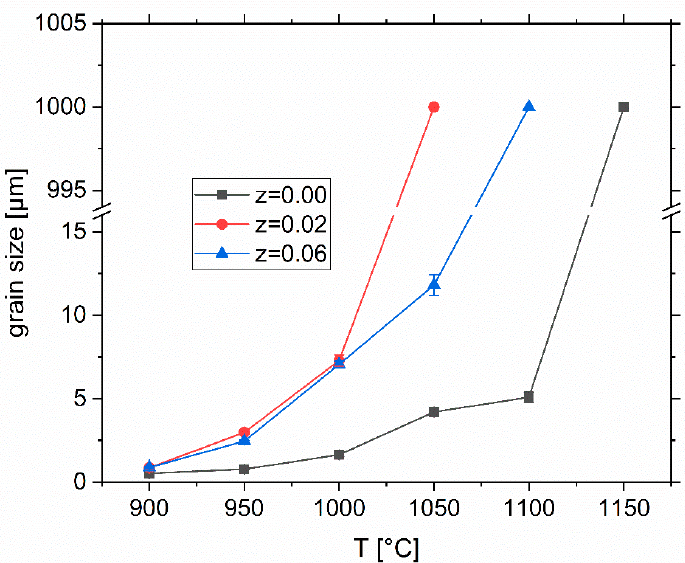
Figure 3. Ferrite grain size vs. sintering temperature for 0 ≤ z ≤ 0.06. Figure 3 . Ferrite grain size vs. sintering temperature for 0 ≤ z ≤ 0.06 .